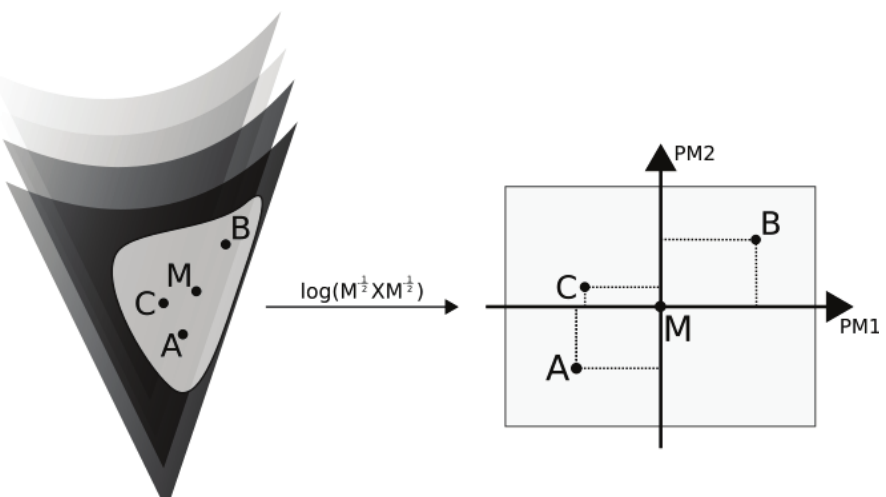
Figure 2. Graphical depiction of the eigentensor decomposition of covariance matrices A, B and C. The mean matrix M is estimated within the non-Euclidean space of symmetric positive-definite matrices; the transformation − − =